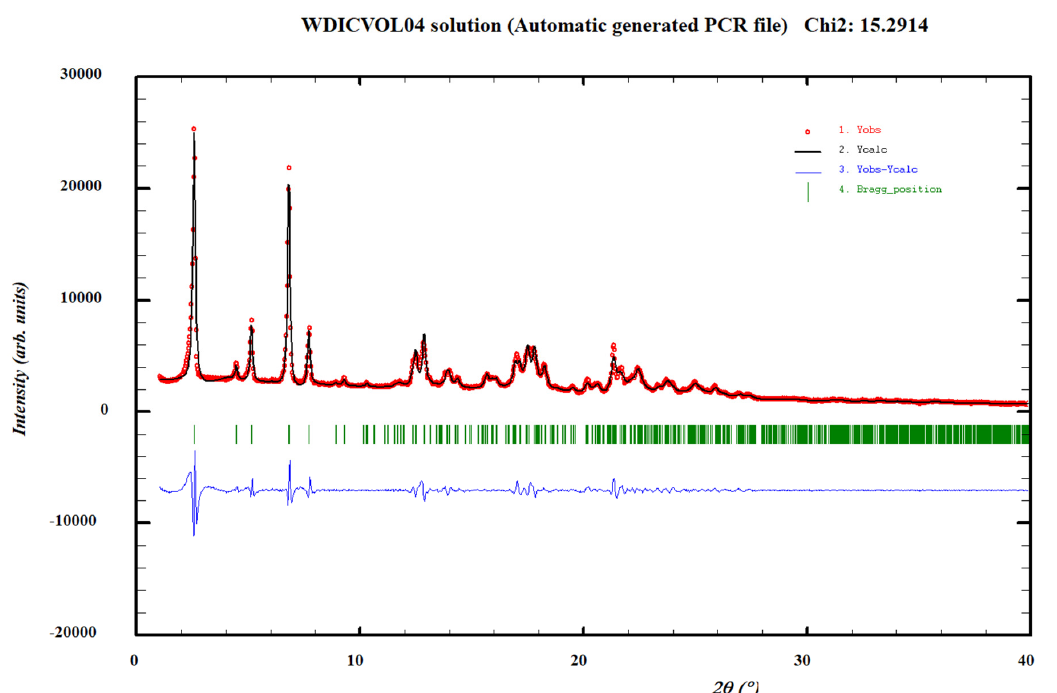
Figure 5. Pattern matching refinement of the AD–orcinol cocrystal. Agreement factors: R wp : 7.93%; R exp : 2.03% (Chi-square: 15.29). Experimental XRPD profile (red marks), calculated XRPD profile (black solid line) and the difference between them (blue, line). Tick marks correspond to peak positions (|, in green).